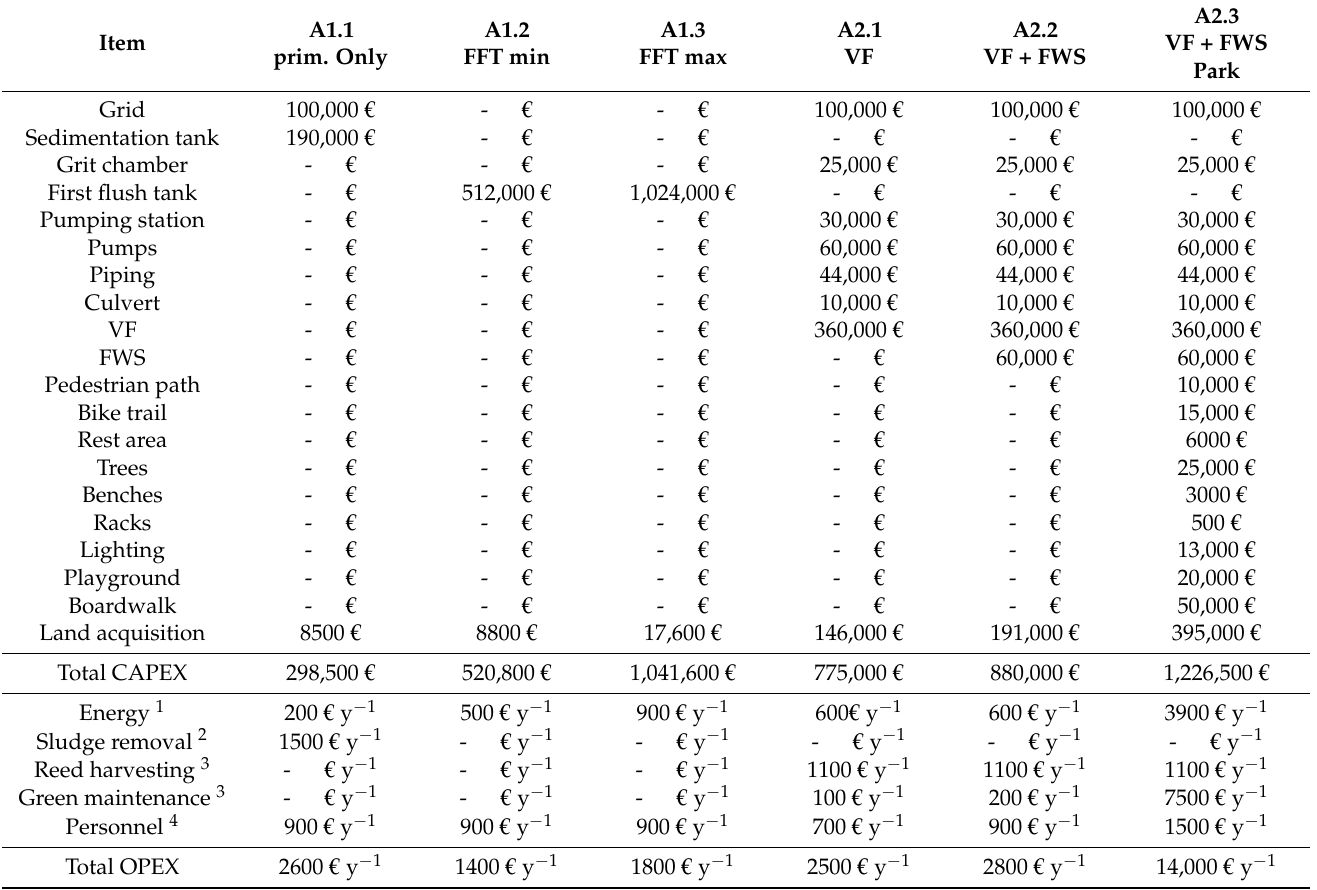
Table 3. Detailed CAPEX and OPEX estimation for all alternatives. A1.1: primary treatment only (prim. only). A1.2: first flush tank, minimum size (FFT—min). A1.3: first flush tank, maximum (FFT—max). A2.1: vertical subsurface flow CW (VF). A2.2, vertical subsurface flow plus free water surface CW (VF + FWS). A2.3, vertical subsurface flow plus free water surface CW in an urban park (VF + FWS